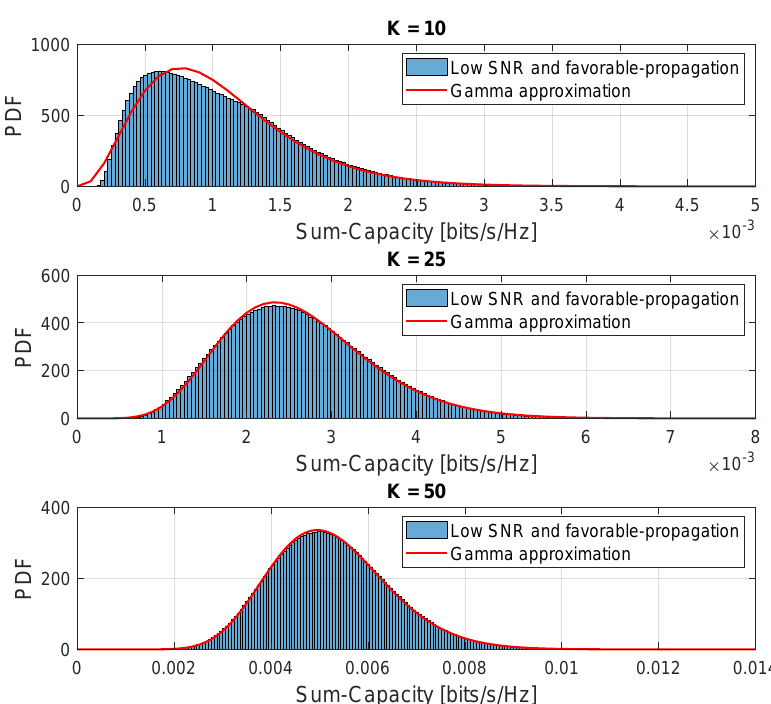
Figure 10. Comparison of the approximated PDF for the instantaneous sum-capacity in the low-SNR regime and favorable propagation condition.